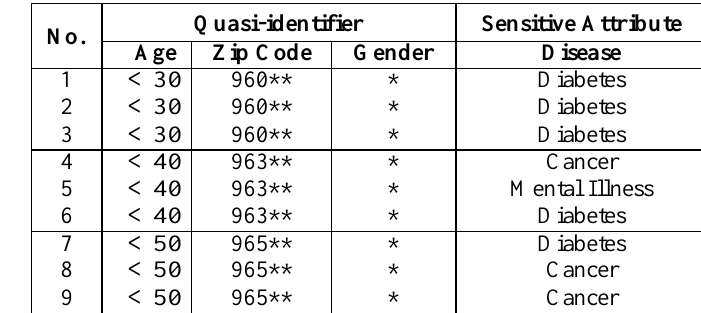
Table 2. Published data of Table 1.